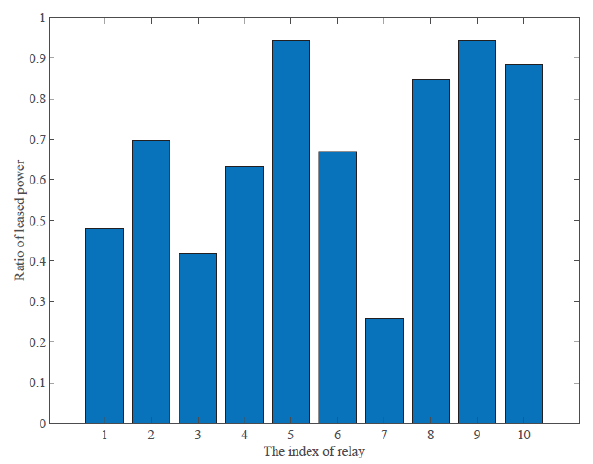
Figure 4. Ratio sum of relayed